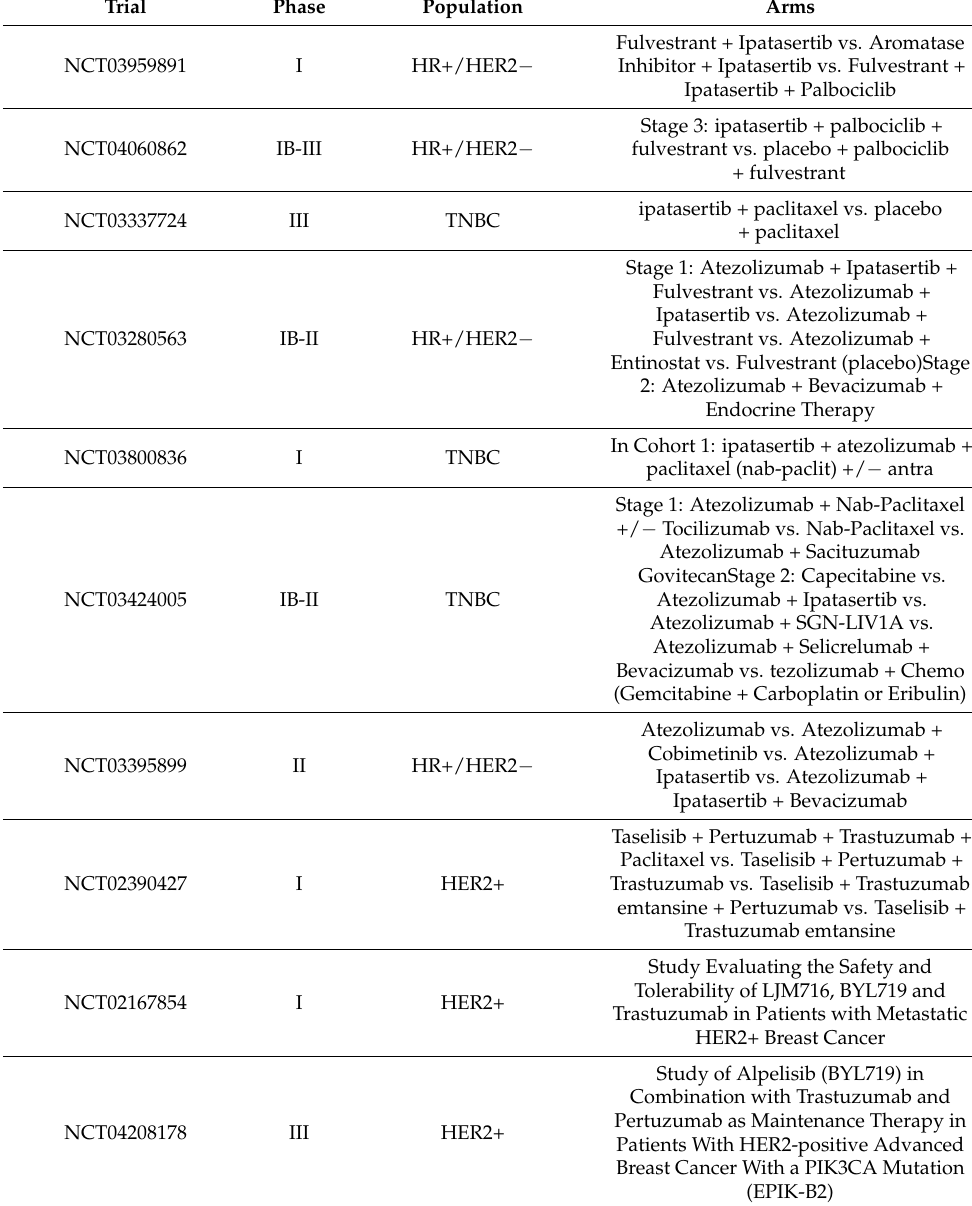
Table 2. Ongoing Trials in